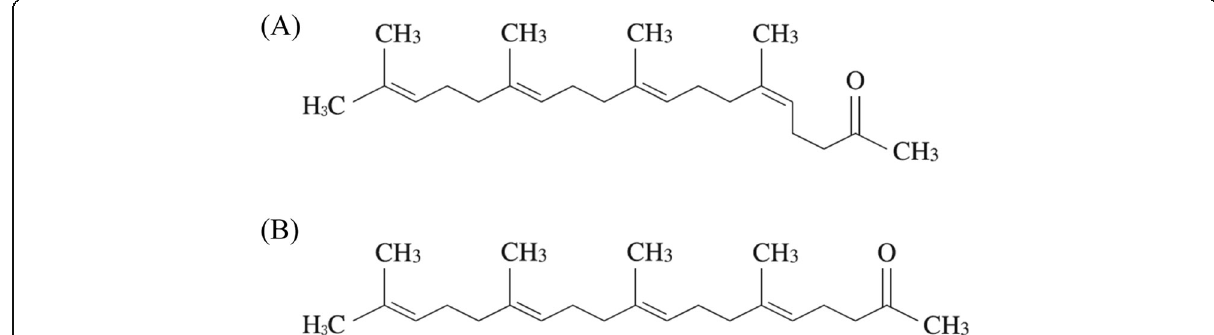
Fig. 1 Chemical structures of ( A ) mono-cis teprenone and ( B ) all-trans